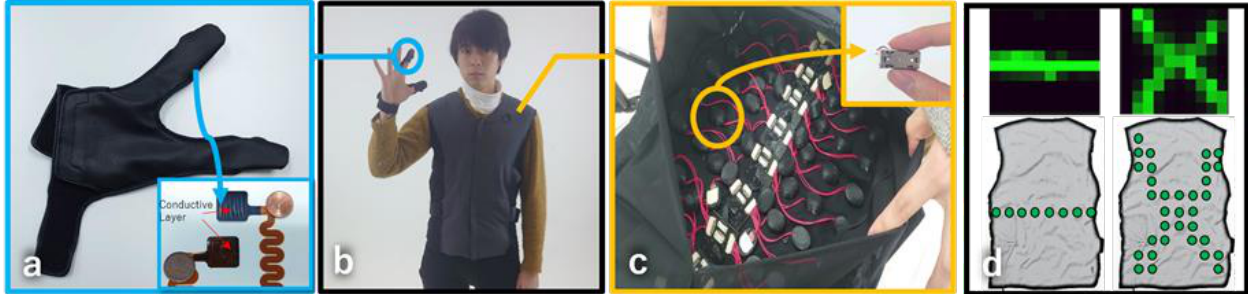
Figure 1. ( a ) Fingertip sensing glove, ( b ) haptics vest, ( c ) inside of haptics vest, ( d ) output of fingertip sensing glove and haptics vest (for example, when touching a model of a horizontal line “ - ” and cross “ × ” the value output by the pressure sensor is visualized, and the part where the actuator of the tactile vest is driven corresponding to the pressure sensor is shown).